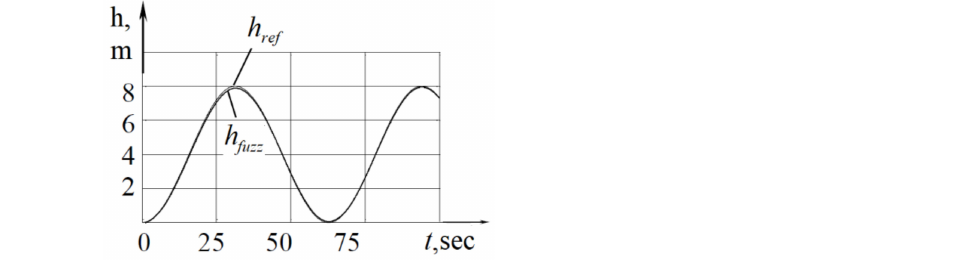
Figure 10. Control of the vertical movement of the MPR with a regulator tuned to a harmonic input signal: h ref is a graph of the depth; h fuzz —control signal.